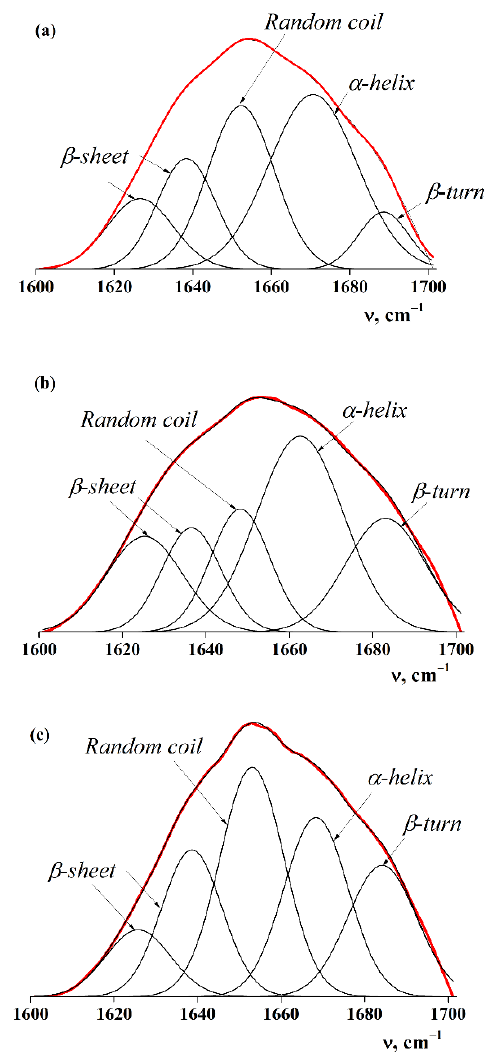
Figure 2. Decomposition of the amide I band (red line) into five spectral lines (black lines) corre- sponding to different conformations of protein molecules using a Gaussian distribution (R 2 = 0.99) for fish protein hydrolysates: ( а ) FPI 4-16; ( b ) FPI 20-16; and ( c ) FPI 20-4.